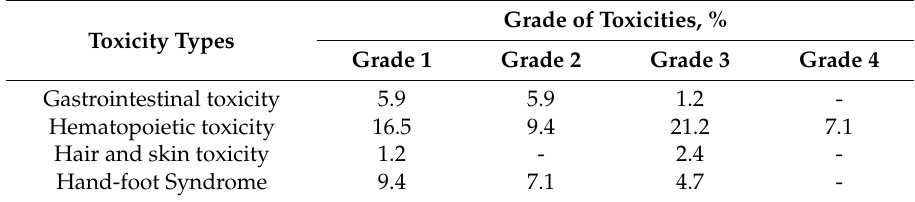
Table 2. Major types of toxicity in patients receiving 5-fluorouracile-based chemotherapy in the first four cycles of